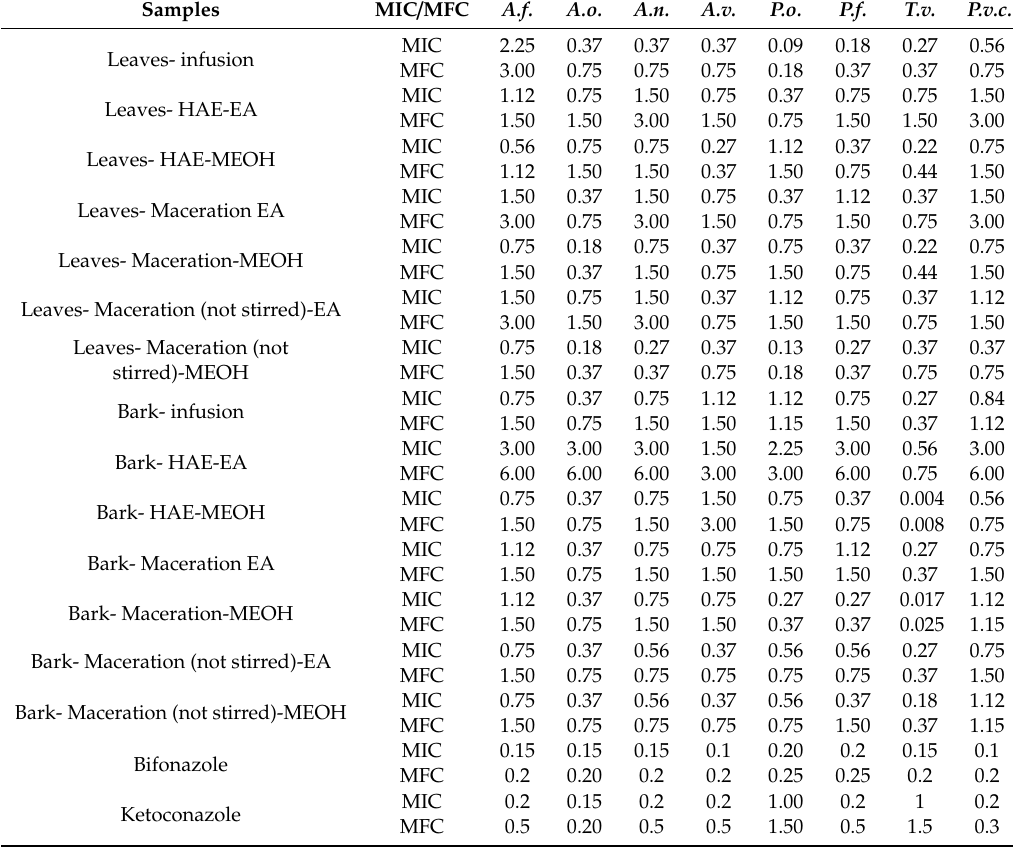
Table 6. Anti-fungal activity of tested samples, results are in mg /